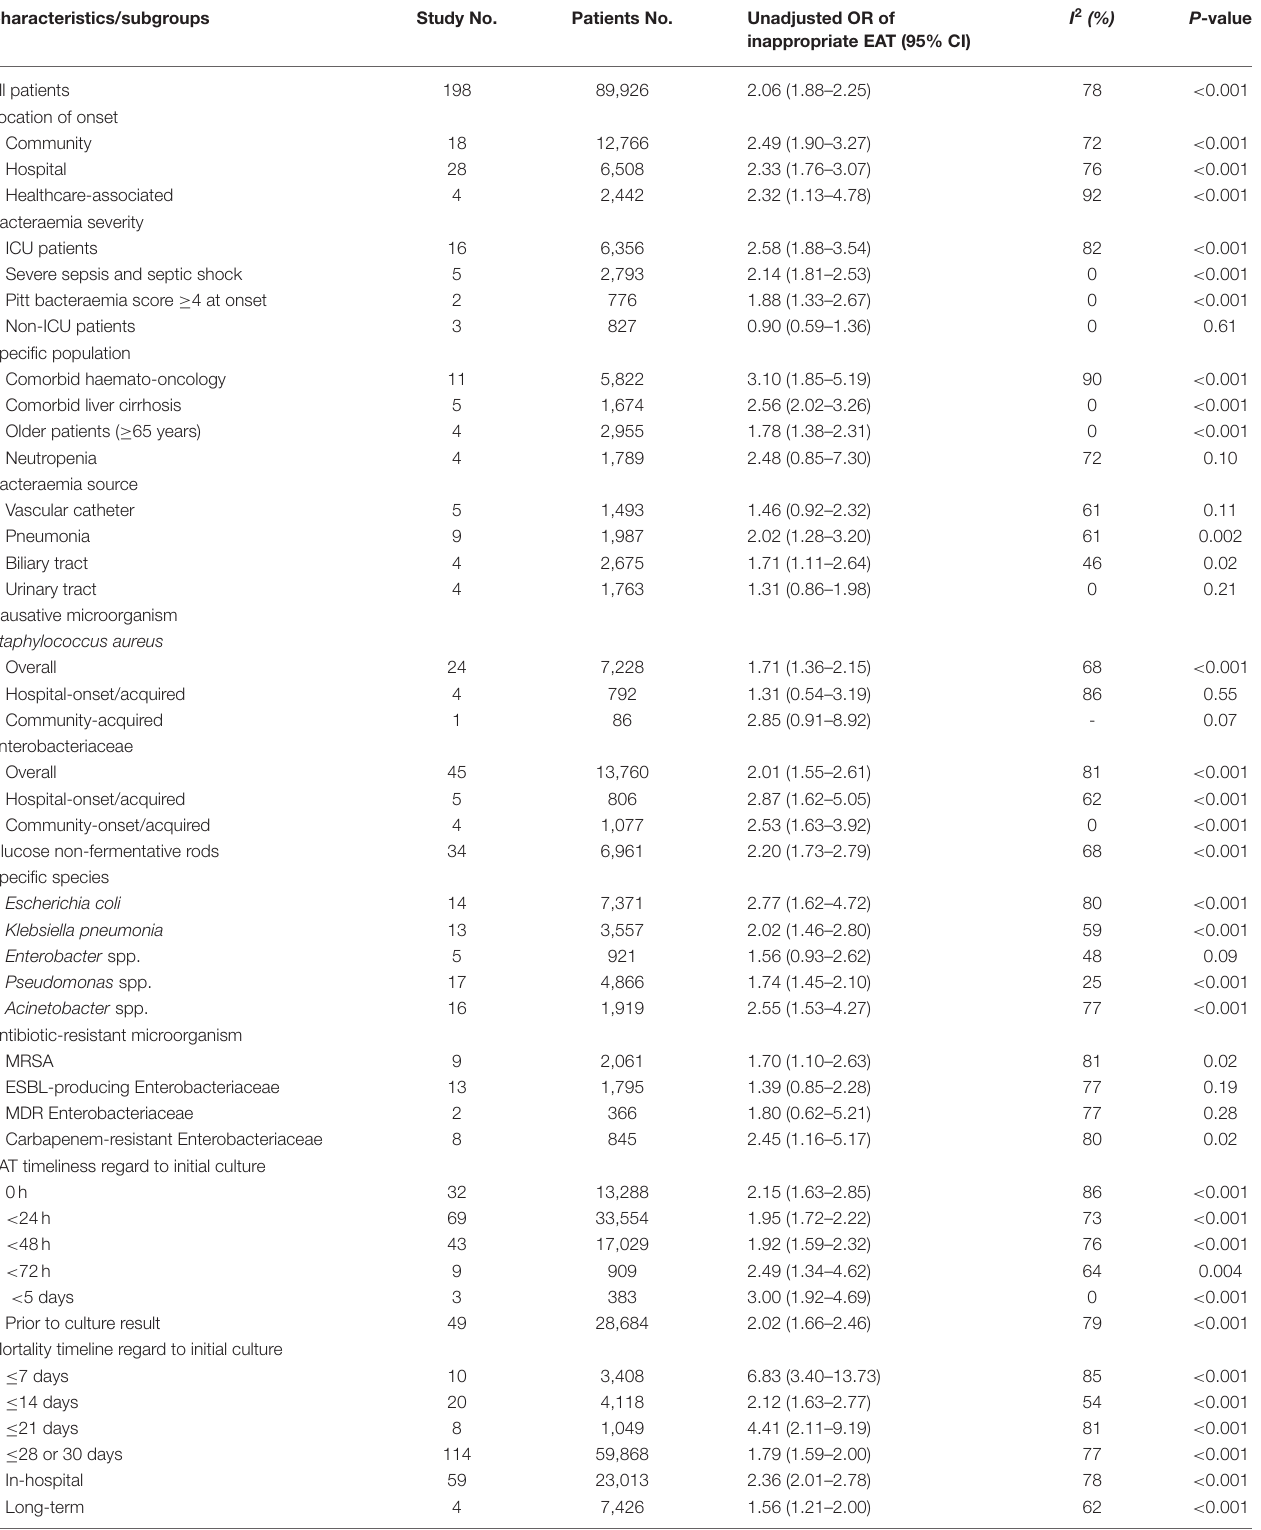
I 2 (%) P -value inappropriate EAT (95% CI)